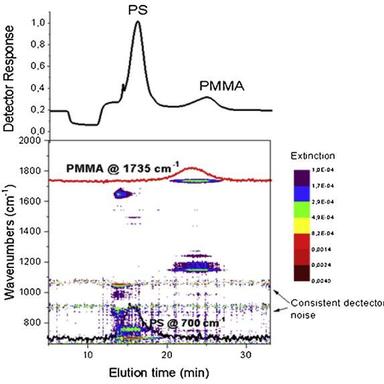
2D contour plot of the ThFFF-FTIR analysis of SM 1, elution profile obtained from dRI detector (top) and elution time vs. FTIR information (bottom), colour code provides peak intensity information in 2D plot.